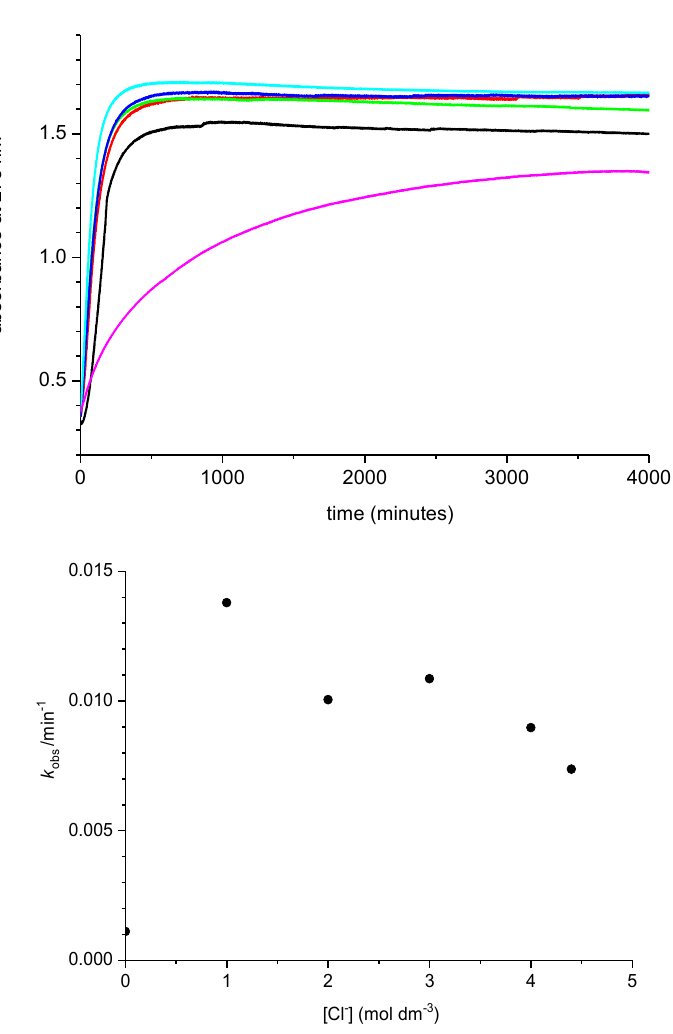
Figure 6. Examples of the absorbance at 278 nm recorded during the homocoupling reaction of 150 μ M 1 in pH 9 borate buffer (10 mM) and catalyst Pd ‐ PPy ‐ PS (1.8 μ M Pd) over the course of 64 h at 30 °C in the presence of 0 M (magenta), 1 M (light blue), 2 M (dark blue), 3 M (green), 4 M (red), and 4.4 M (black) NaCl (Left) and k obs ( ● ) plo tt ed against [Cl − ] for the same reactions (Right). The addition of 1 M chloride or more allows the reaction to reach completion by 12 h at 30 °C.